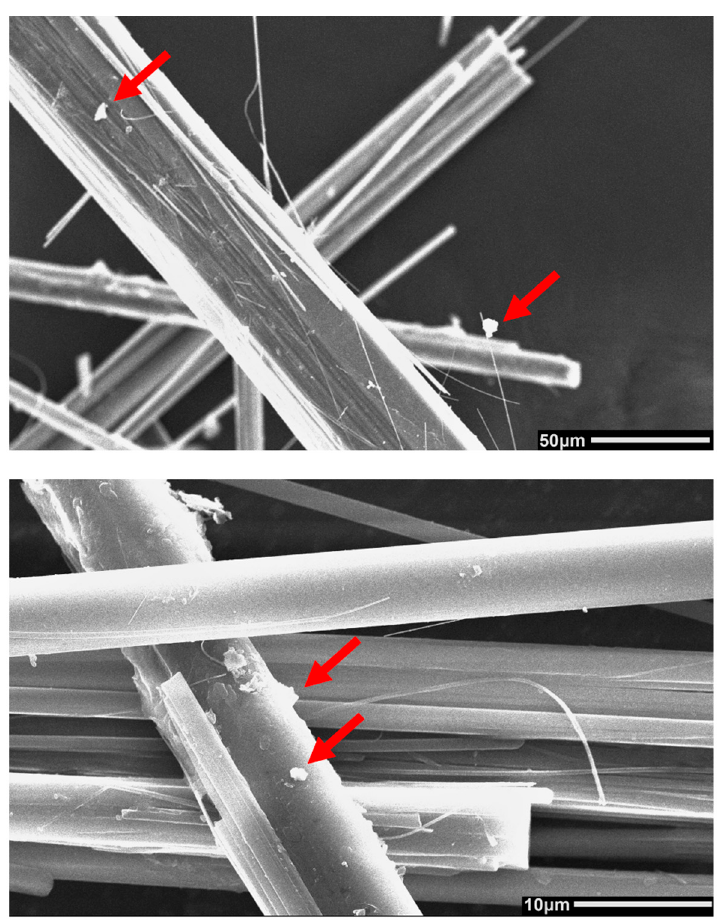
Figure 3. SEM images of mordenite fibers. Both images show mordenite fibers and particles on their surface (maybe hematite or goethite [65]). Some particles are pointed out with red